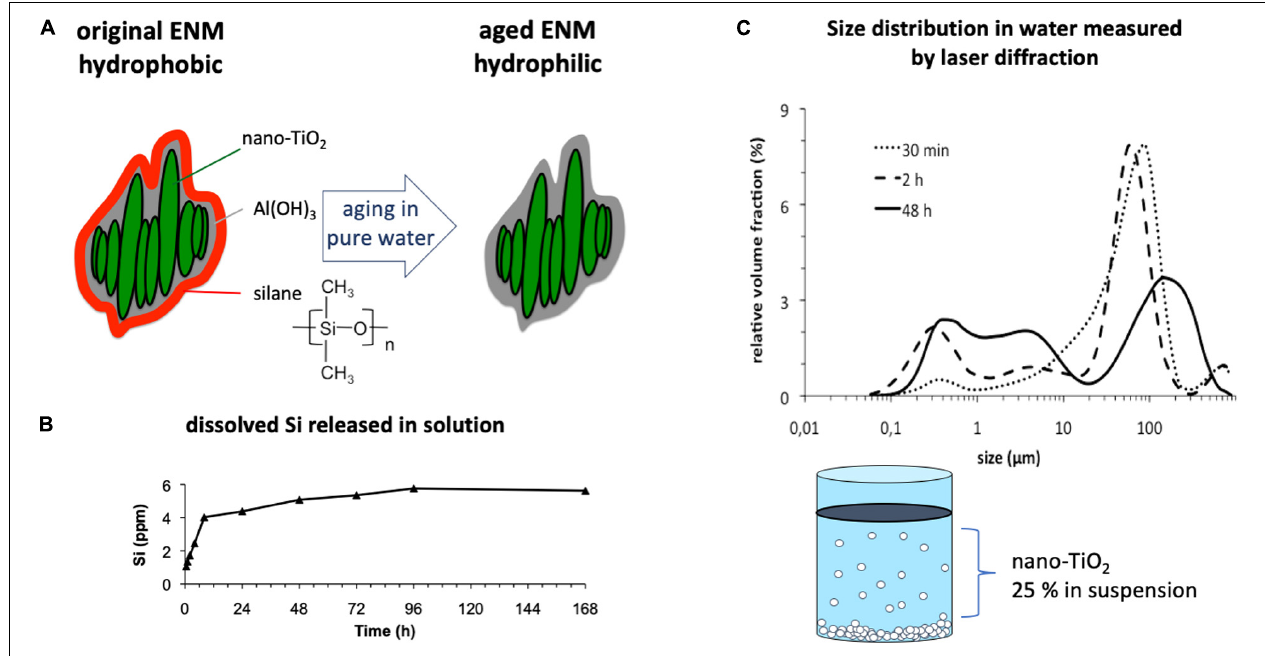
FIGURE 5 | Aging of a hydrophobic TiO 2 ENM coated with Al(OH) 3 /PDMS in pure water (A) . The polydimethylsiloxane (PDMS) coating alteration is confirmed by dissolved Si release (B) and leads to aqueous dispersion and colloidal stabilization (C) due to new hydrophilic Al(OH) 3 surface (Labille et al., 2010).